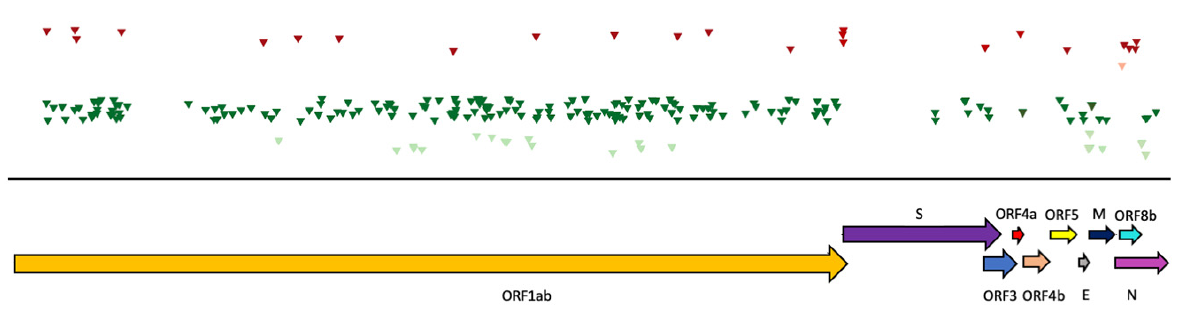
Figure 4. Overview of single nucleotide variants (SNVs) distributed over the genome of MERS-re- lated-CoV from the AG colony. Arrows show the position of the ORFs. Each triangle indicates an SNV; light green, synonymous and novel; dark green, synonymous; light red, non-synonymous and novel; dark red, non-synonymous.